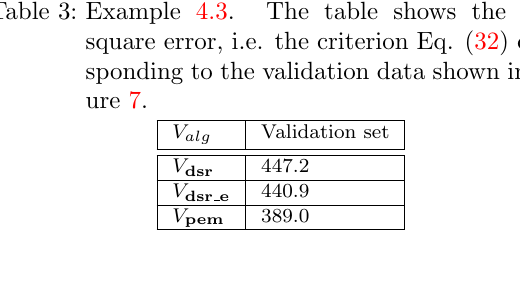
Table 3: Example